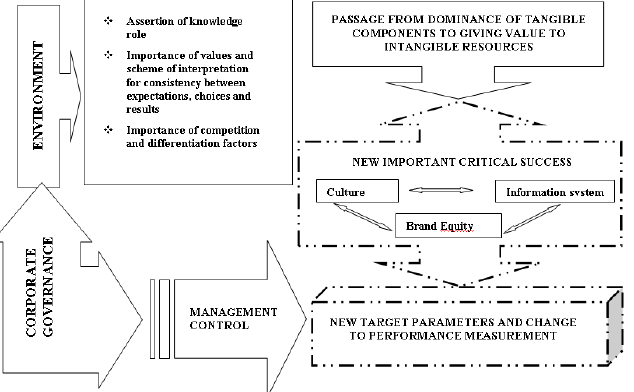
Figure 4: Variations to Critical Success